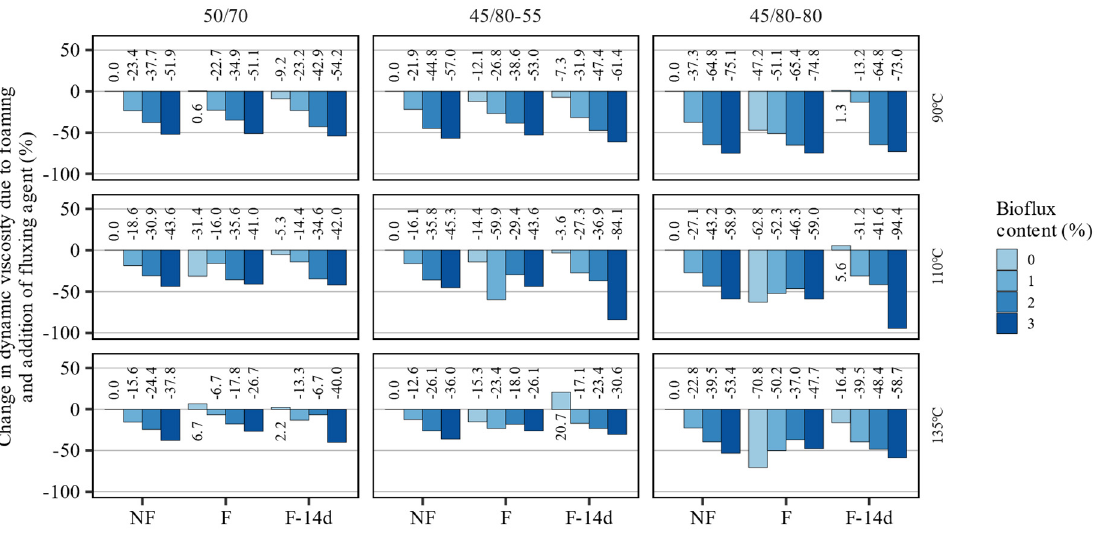
Figure 6. Relative changes in dynamic viscosity measurements of the investigated asphalt binders due to foaming and application of the fluxing agent.